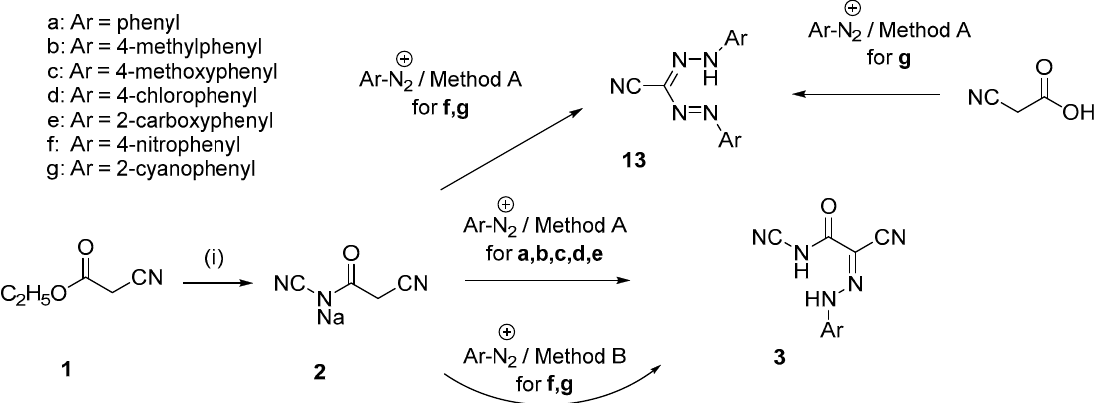
Molecules 2019 , 24 , x